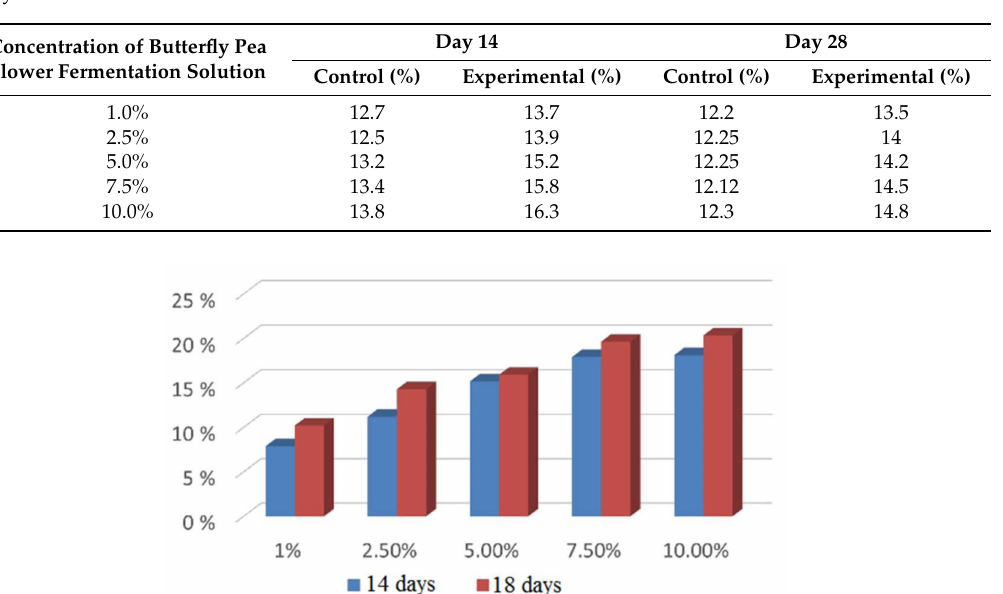
Table 3. Moisture values of the fermentation solutions at different concentrations after 14 days and 28 days of use.